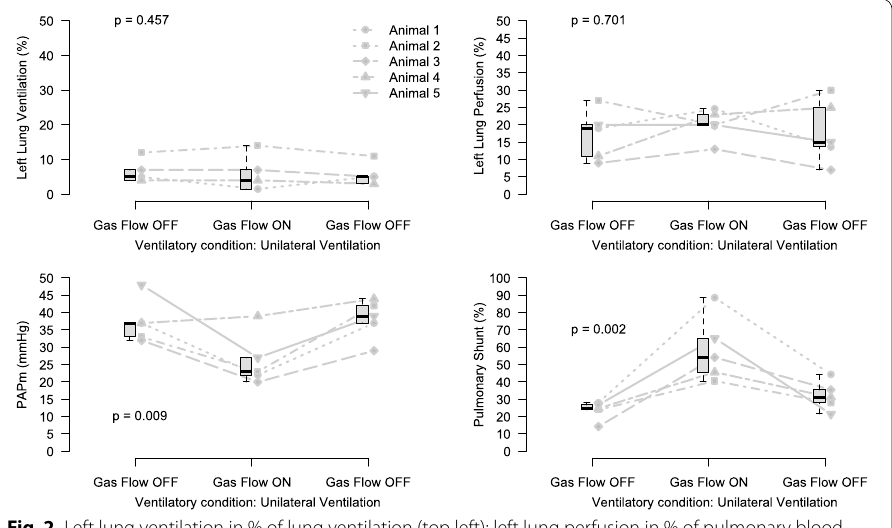
Fig. 2 Left lung ventilation in % of lung ventilation (top left); left lung perfusion in % of pulmonary blood flow (top right); mean pulmonary artery pressure (bottom left); pulmonary shunt (bottom right). Gas flow OFF denotes no ECMO support due to the absence of gas flow. Gas flow ON denotes the initiation of